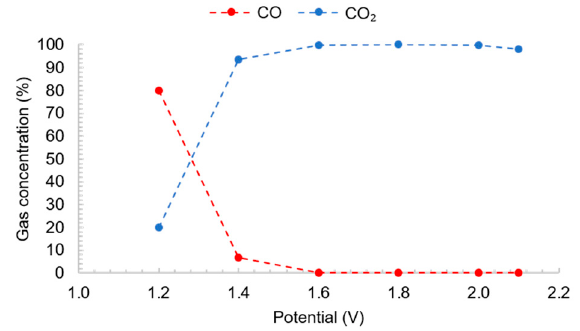
Figure 19. Drossbach’s tabulated data plotted [15].